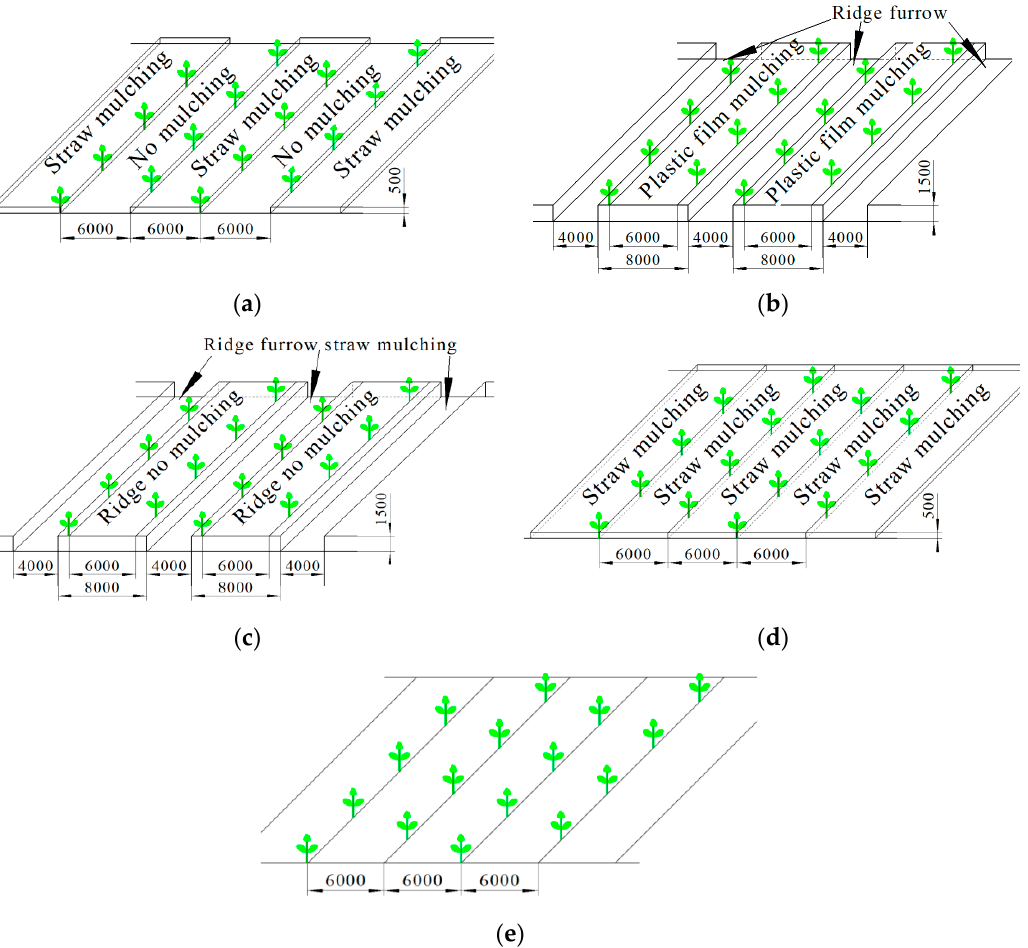
Figure 2. ( a – e ) The potato cultivation practices in the experimental field plots in Tongwei County of Gansu Province, Northwest China, in 2015 and 2016. They were: ( a ) maize straw strip mulching on flat planting (SMF); ( b ) alternating large ridges and small furrows with only the ridges mulched with black polyethylene film (PMF); ( c ) maize straw strip mulching on furrow and ridge planting (SMFR); ( d ) straw fully covered flat planting (SMWF); ( e ) traditional bare land planting without mulching (CK).